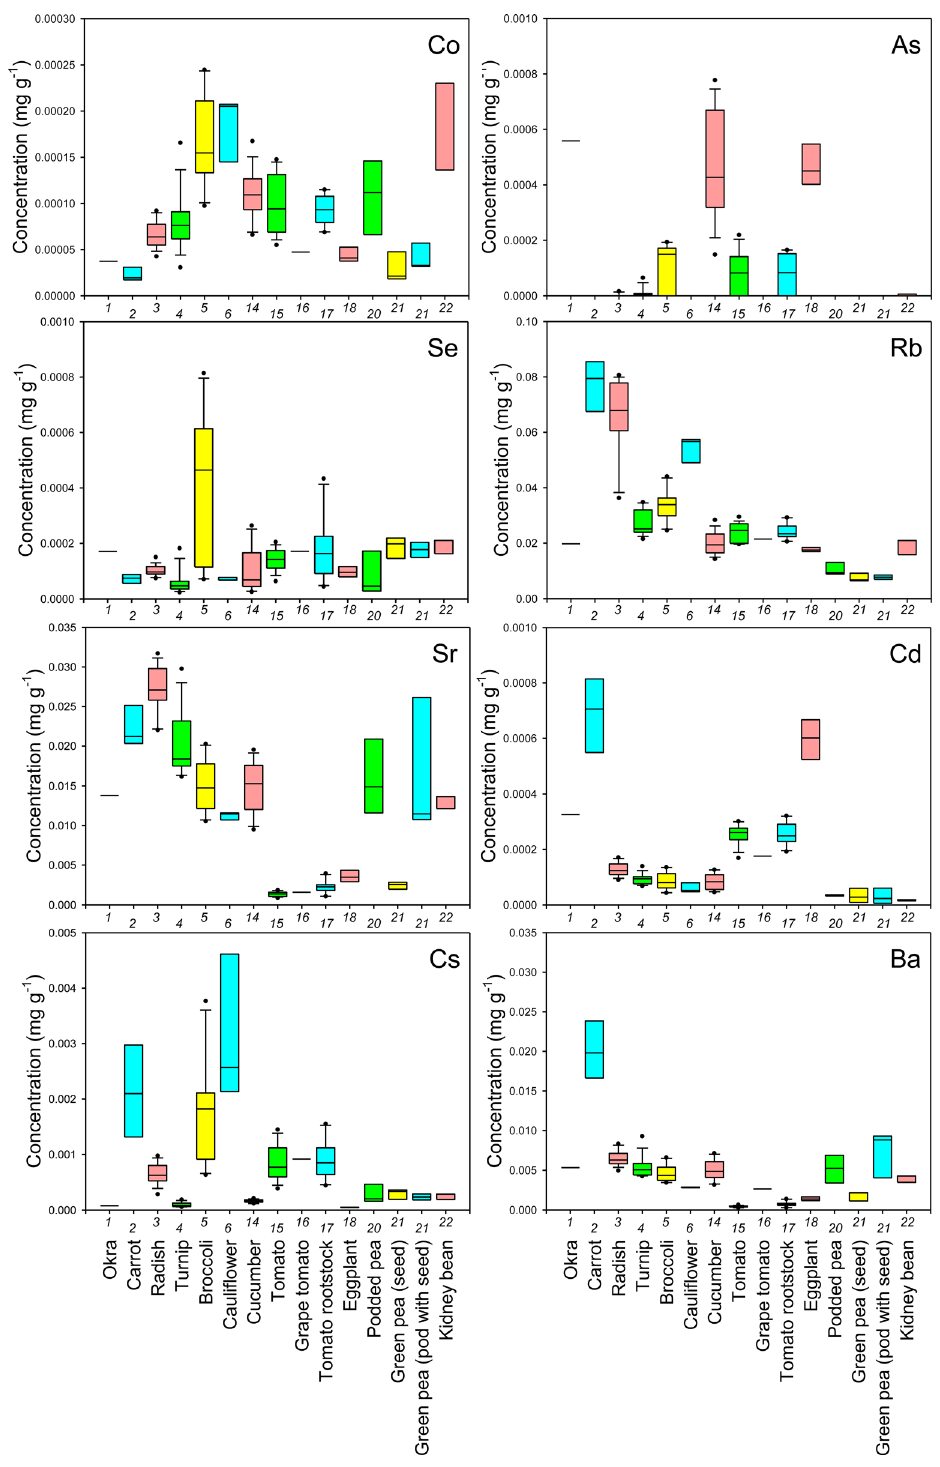
Fig 6. Boxplots showing the concentration of Co, As, Se, Rb, Sr, Cd, Cs, and Ba in non-leaf edible parts of various crop species. Numbers in x-axis indicate the species number in Table 1.